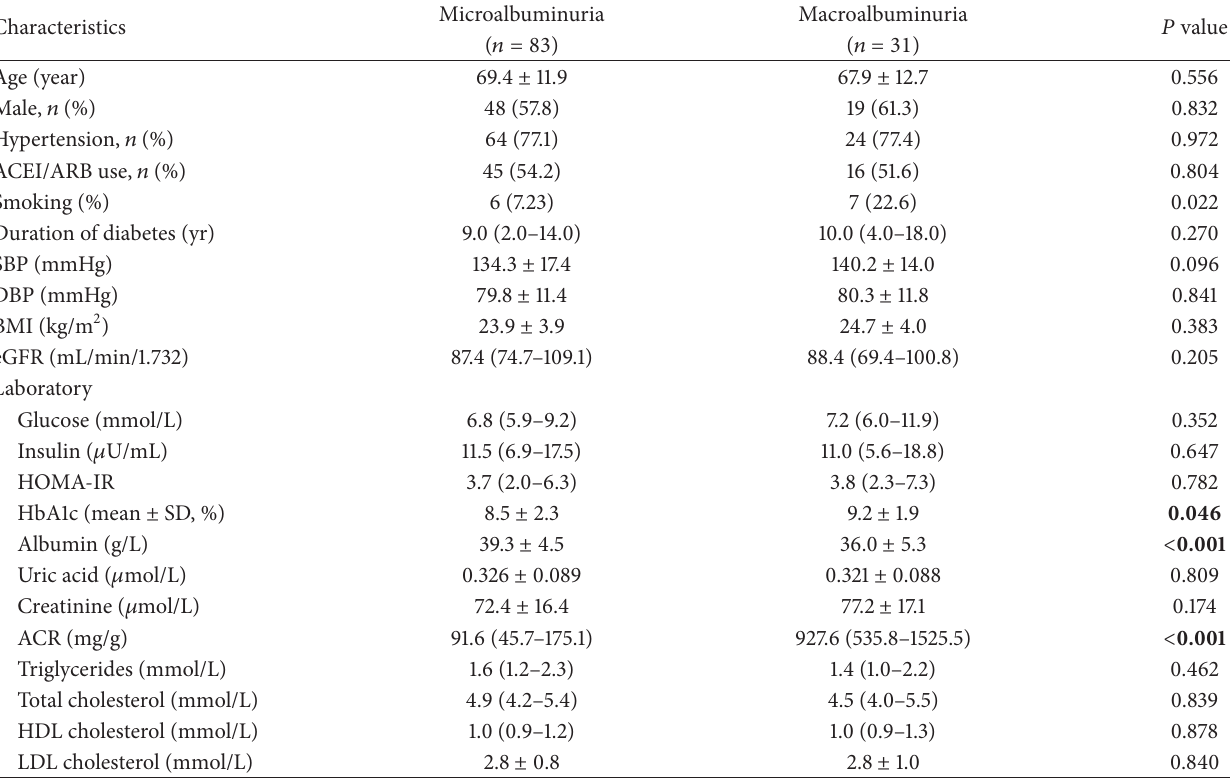
Table 2: The main clinical and biochemical characteristics of type 2 diabetic patients with early diabetic nephropathy.